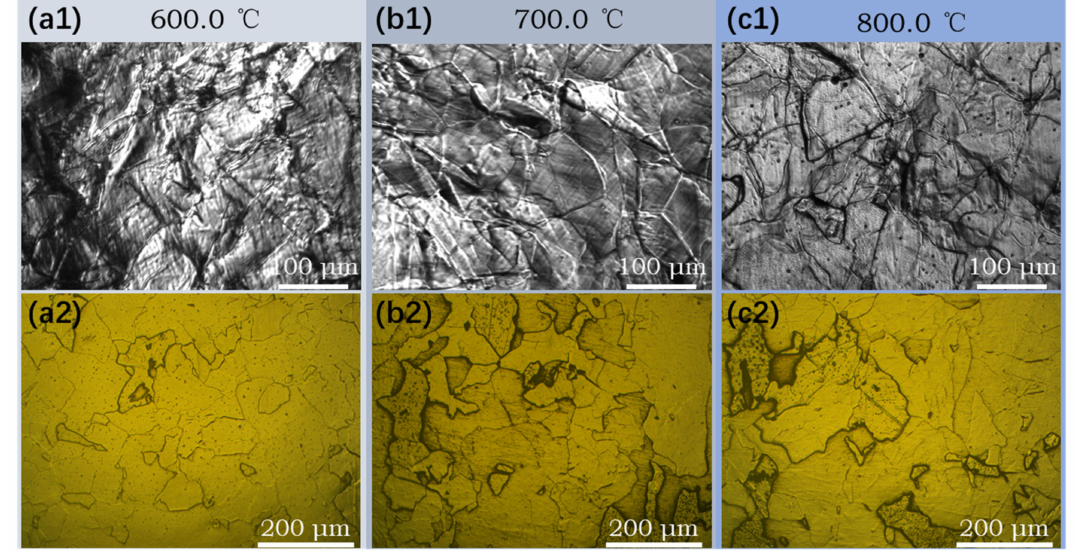
Figure 10. CLSM pictures and optical microstructures after coiling simulation at ( a ) 600 ◦ C, ( b ) 700 ◦ C, and ( c ) 800 ◦ C,